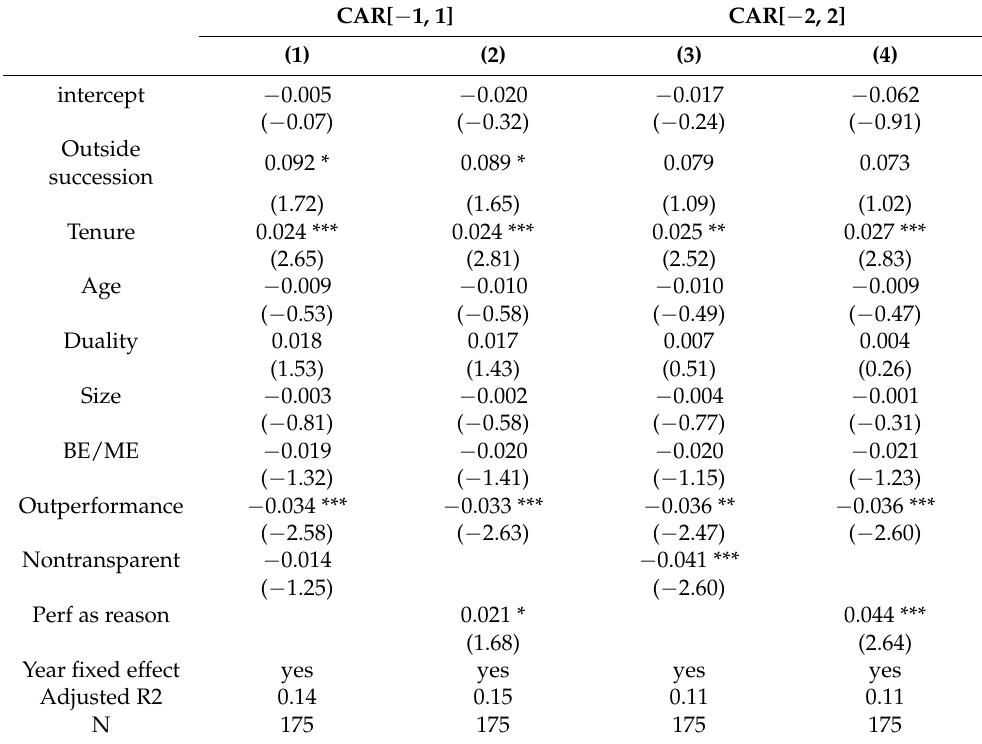
Table 8. Regressions with alternative benchmark for expected returns for under- and outperforming CEO